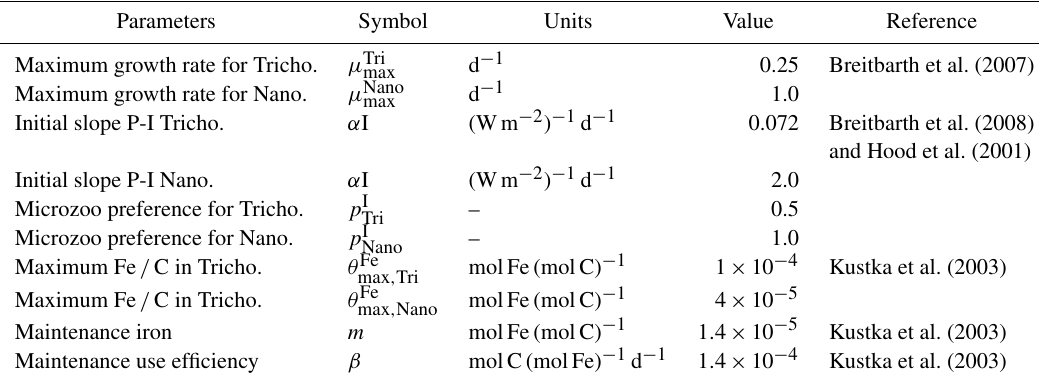
Table 2. List and description of the different